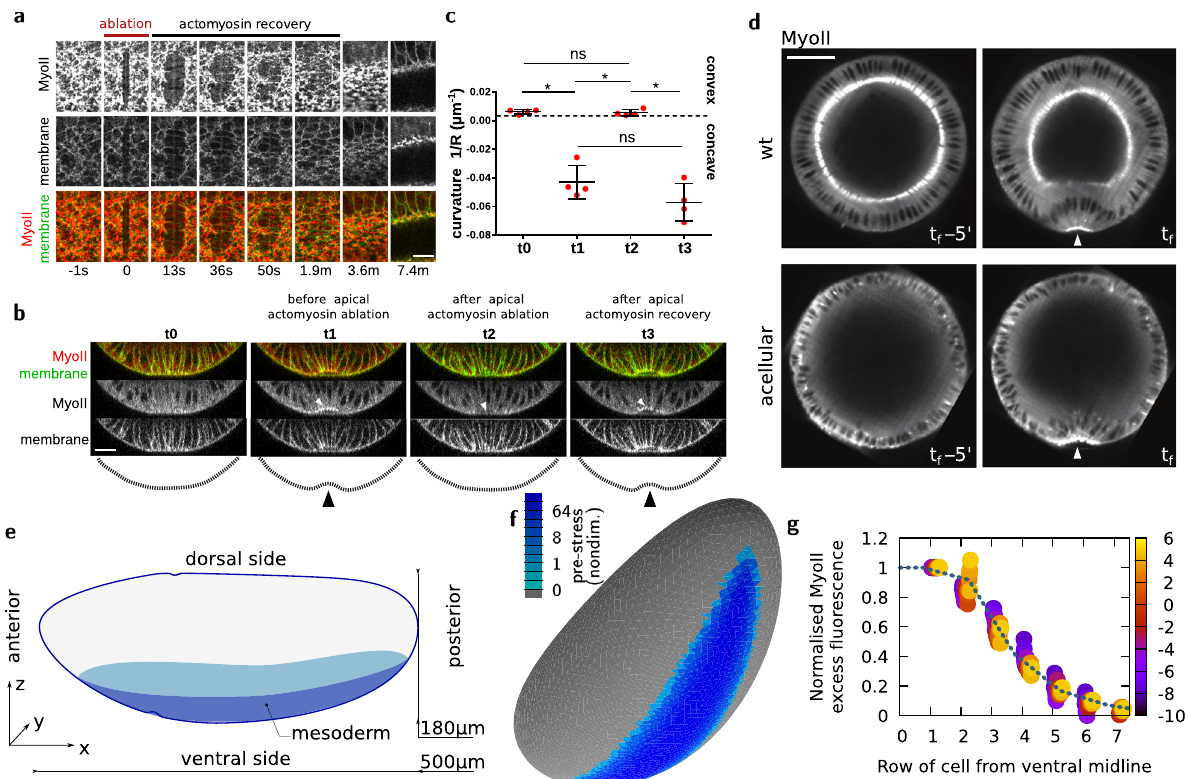
Fig. 1 Using IR fs laser ablation to demonstrate the necessity and building of a model to test the suf fi ciency of apical contraction to drive VFF. a Recoil and recovery of the ventral apical actomyosin network after laser ablation. The ablation is performed along the DV axis across the ventral tissue. MyoII is depleted along the ablated region while membrane signal density eventually decreases as a consequence of cell dilation. Panel shows representative experiment. Experiment repeated 5 times on 5 different embryos. Scale bar 10 μ m. b Cross-sectional view of the embryo ventral side just before ( t 0 and t 1) and just after ( t 2) laser ablation, and ( t 3) after actomyosin recovery. Time between t 0 and t 3 is 3 min. Laser ablations were performed similarly as in ( a ). Panel shows representative experiment. Experiment repeated 4 times on 4 different embryos. Scale bar 20 μ m. c Curvature analysis before and after laser ablation and during actomyosin network recovery as shown in ( b ). n = 4 embryos, data are presented as mean values ± standard deviation. The statistical test performed was Kruskal – Wallis test for multiple comparisons, * p ≤ 0.05 and ns (non-signi fi cant), p > 0.05. d Digital mid-cross-sections before and during furrow formation in wild-type and slam − dunk − acellular embryos. Panel shows representative case, n = 4 embryos. Scale bar 50 μ m. e Representation of the embryo geometry with the mesoderm region highlighted. f Finite element mesh of an embryo-shaped elastic surface where some facets will be pre-strained to mimic MyoII activity (colour code, log scale, nondim. nondimensional units). g Circles, MyoII pro fi le at different phases of VFF as a function of distance from the ventral midline, normalized using the intensity of cells at midline (row 0, see the “ Methods ” section), in experiments (average of n = 3 embryos, confocal microscopy). Line, pre-stress pro fi le chosen for simulations. This pro fi le is also similar to the one reported by ref. 33